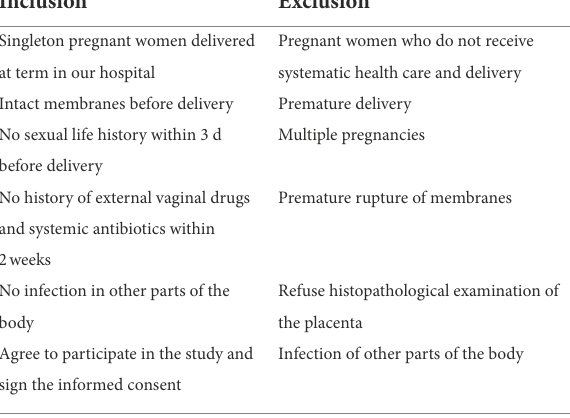
TABLE 1 Inclusion and exclusion